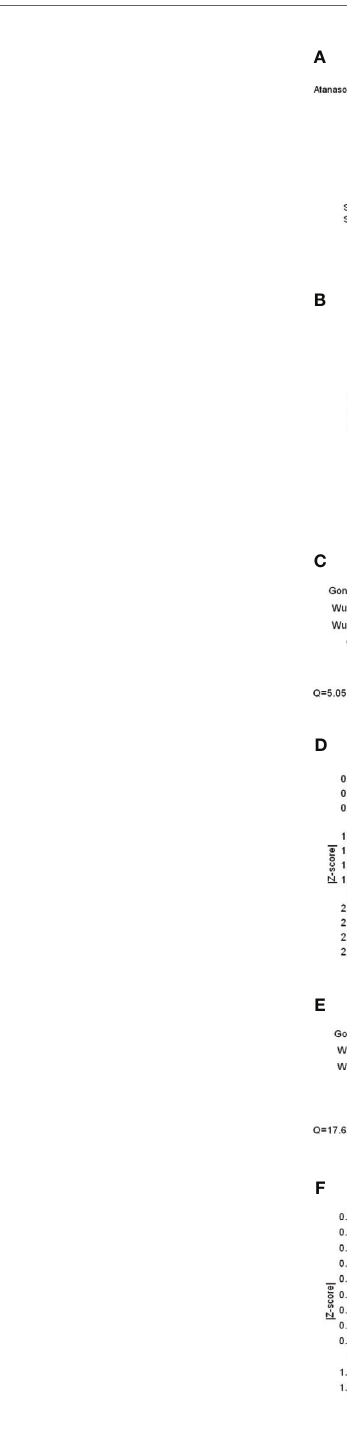
FIGURE 3 | The association of Th2-related cytokine polymorphism with chronic periodontitis. (A) Forest plot of the association of IL-4 − 590 C/T T allele polymorphism with chronic periodontitis. (B) The Doi plot is used to visualize the asymmetry of the association of IL-4 − 590 C/T T allele polymorphism with chronic periodontitis using the LFK index. (C) Forest plot of the association of IL-13 − 1112C/T C allele polymorphism with chronic periodontitis. (D) The Doi plot is used to visualize the asymmetry of the association of IL-13 − 1112C/T C allele polymorphism with chronic periodontitis using the LFK index. (E) Forest plot of the association of IL-13 − 1112C/T T allele polymorphism with chronic periodontitis. (F) The Doi plot is used to visualize the asymmetry of the association of IL-13 − 1112C/T T allele polymorphism with chronic periodontitis using the LFK index. LFK index zero represents complete symmetry, the limits of symmetry were set at ±1, and values beyond ±1 were inconsistent with